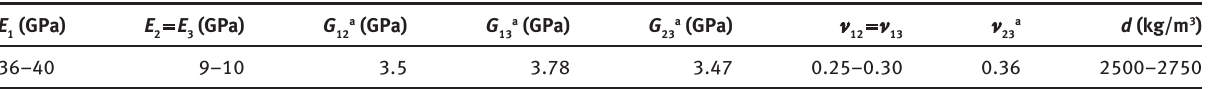
Figure 4: Composite mono-leaf spring material orientation with discrete coordinate system. Table 5: Mechanical properties of UD E-glass/epoxy plies.